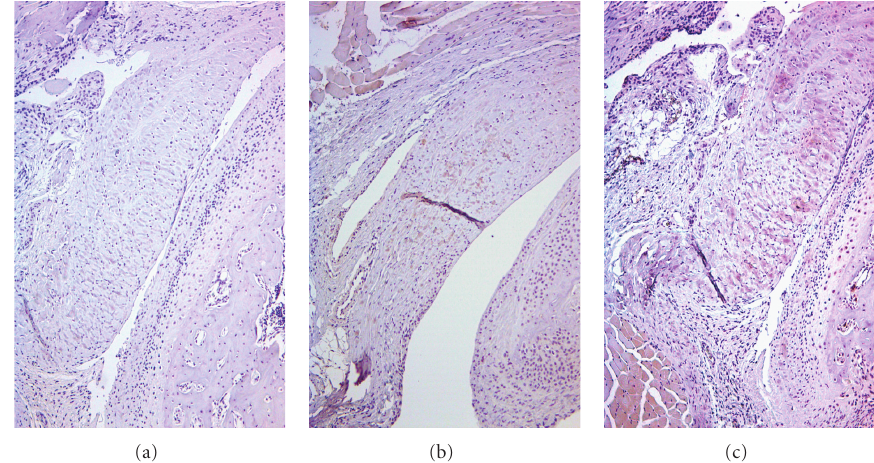
Figure 5: Photomicrographs of the immunostaining for iNOS in the TMJ and periarticular tissues of zymosan-induced TMJ arthritis in rats. (a) Negative control (sections in the absence of anti-iNOS antibody) of arthritic rats (100x). (b) Normal rat TMJ showing light immunostaining for iNOS (100x). (c) TMJ arthritis induced by zymosan 2mg showing strong immunostaining for iNOS in chondrocytes and synoviocytes